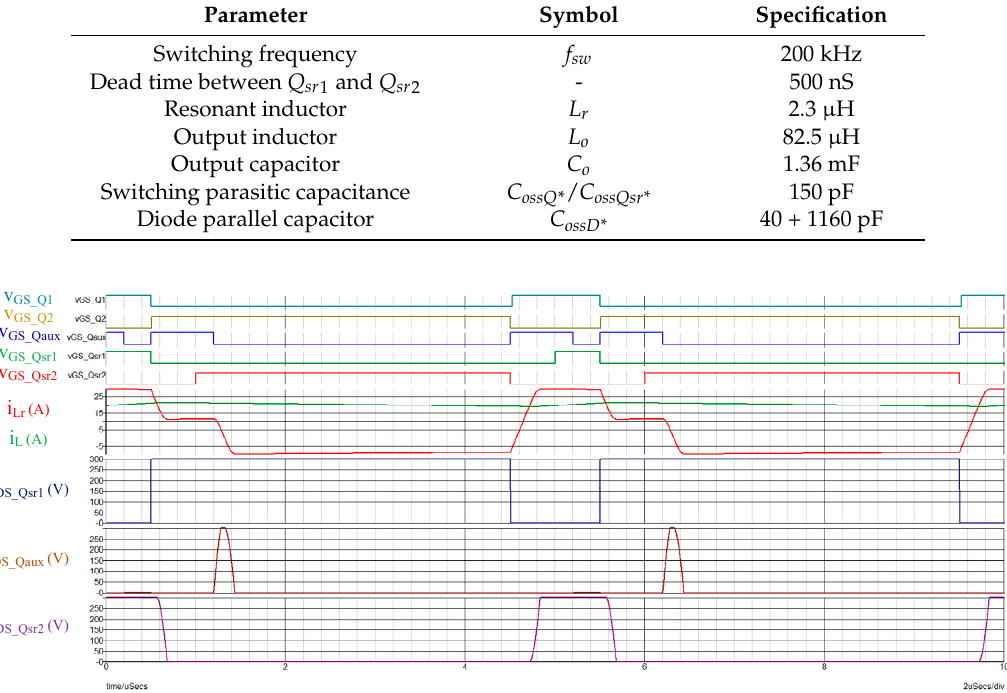
Figure 13. Simulation results: v GS and v DS waveforms of each switch, resonant inductor and output inductor current waveform at V O = 50 V, Io = 20 A.